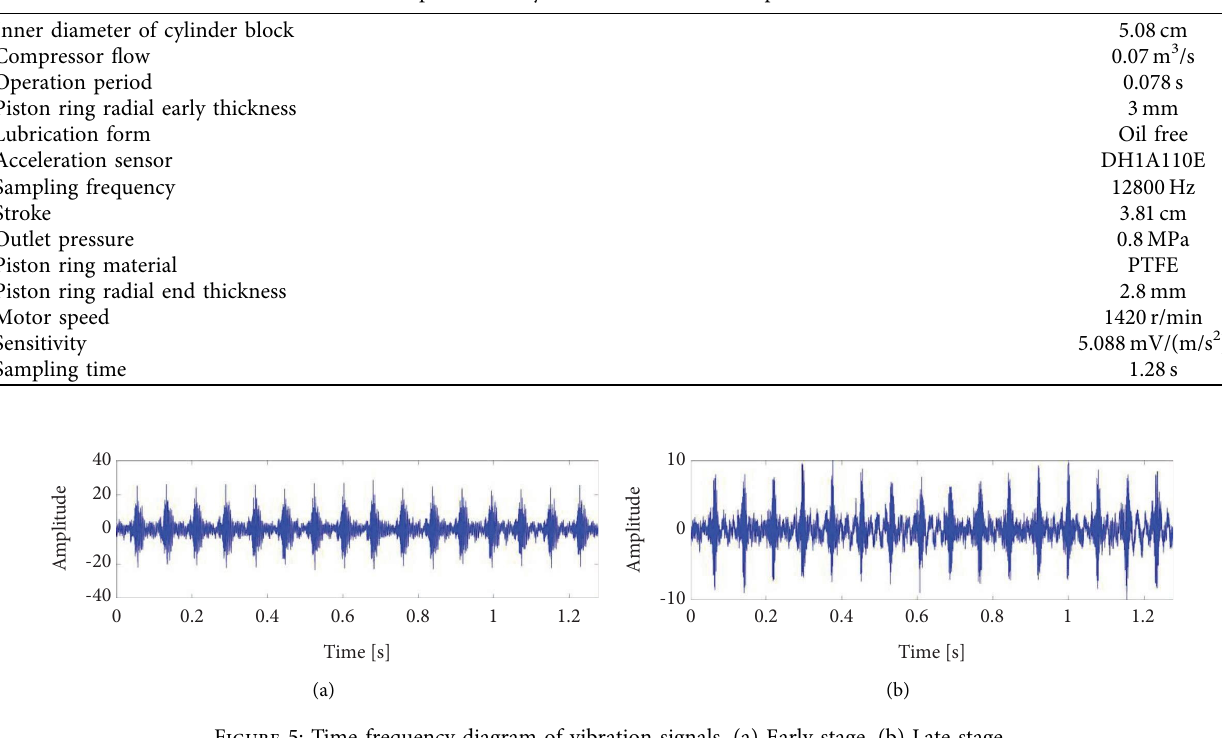
Table 1: Experimental system and structure size parameter table.